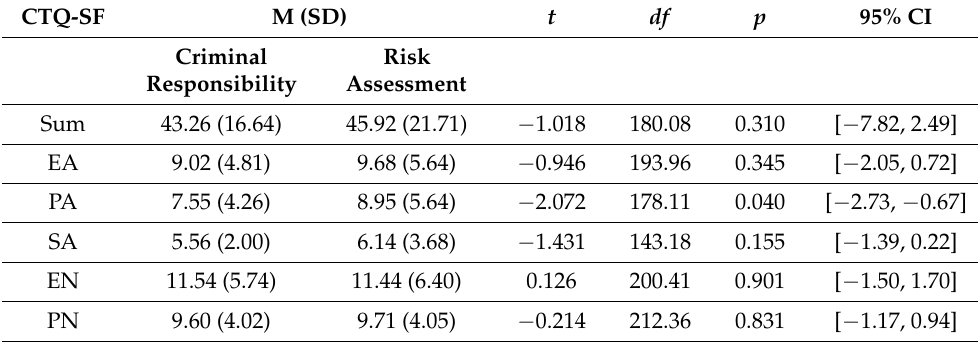
Table 6. Comparison of the Mean Self-Assessment Scores between the Criminal Responsibility ( n = 131) and Risk Assessment ( n = 100) Groups.